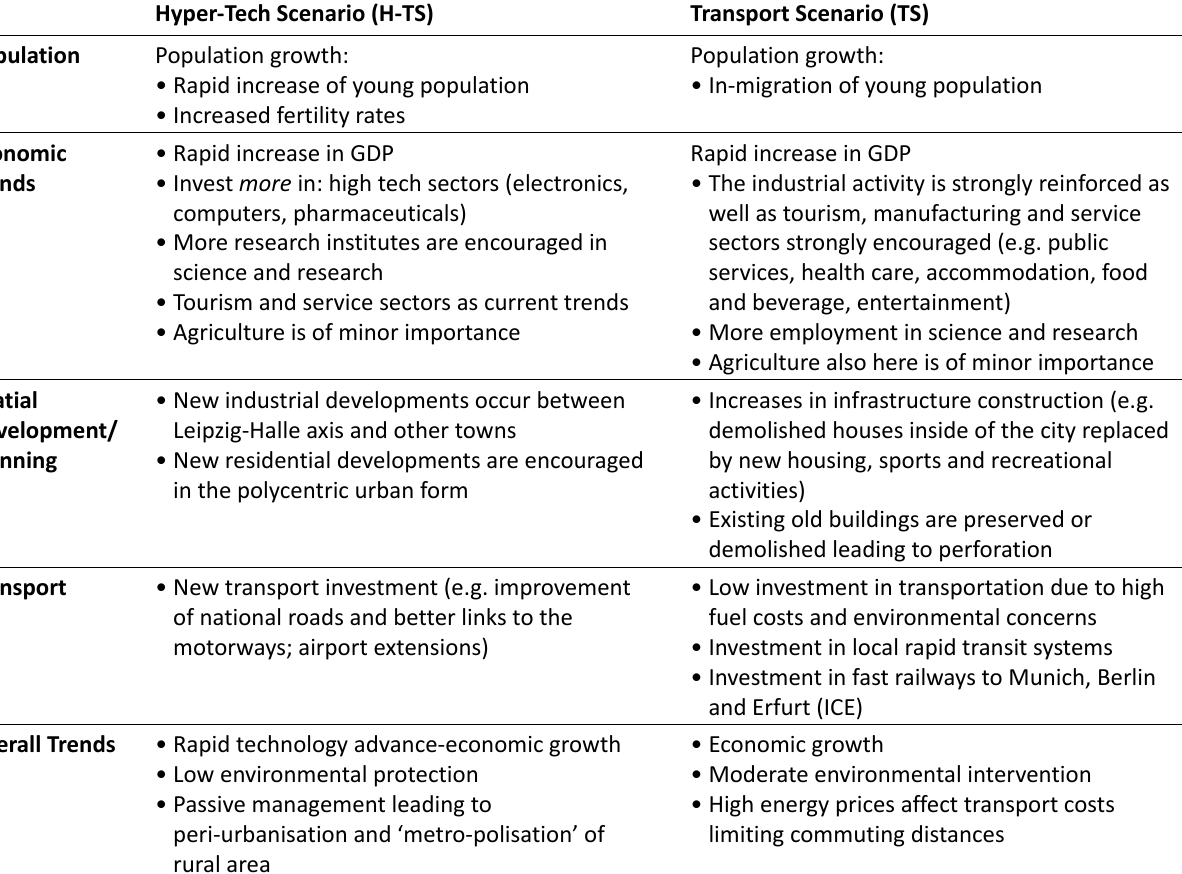
Table 4. Characteristics of urban development scenarios in the Leipzig-Halle